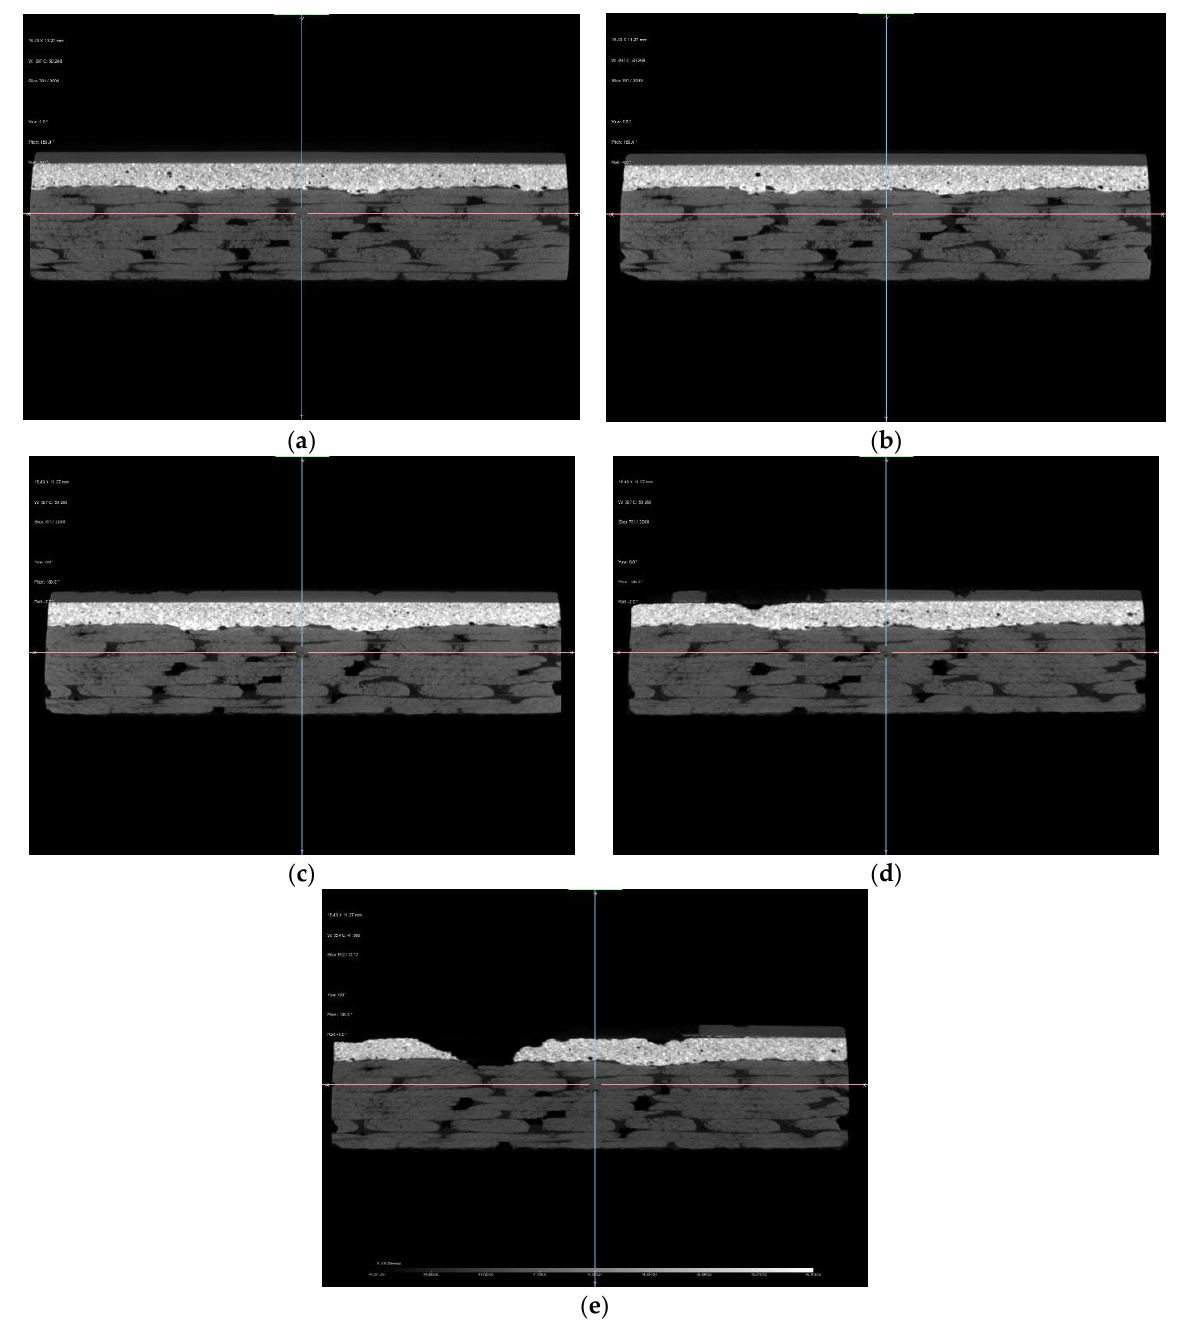
Figure 5. XCT images of samples from each erosion stage: ( a ) Stage 1; ( b ) Stage 2; ( c ) Stage 3; ( d ) Stage 4; ( e ) Stage 5.